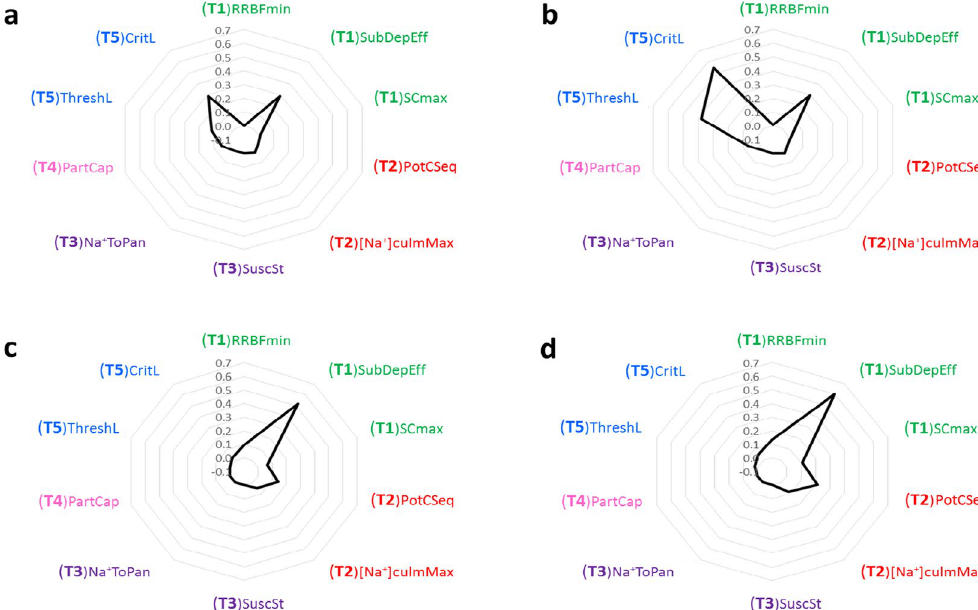
Figure 3. Sobol’ first- ( a , c ) and total-order ( b , d ) effects calculated for the sensitivity analysis performed on model parameters representing salt tolerance traits (Table 1). The Sobol’ sensitivity metrics for a parameter indicate the portion of output variance explained by changes in the value of that parameter alone (first-order effect) and of that parameter in interaction with all the others (total-order effect). The analysis was carried out for two scenarios, one in California ( a , b ) and the other in Greece ( c , d ). The output for which sensitivity metrics were calculated was the final yield.